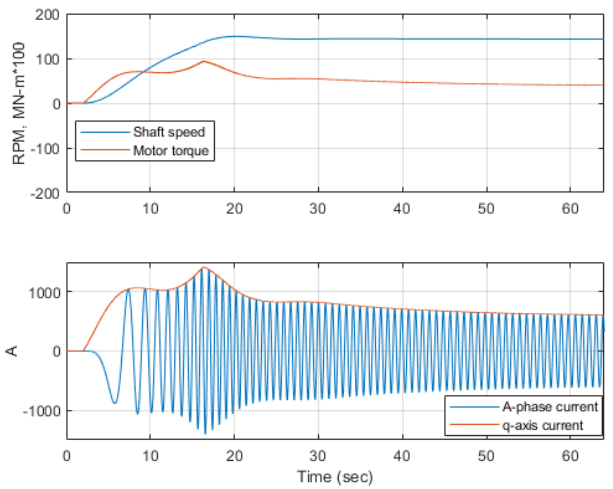
Figure 15. Motor current performance during ice breaking scenario.